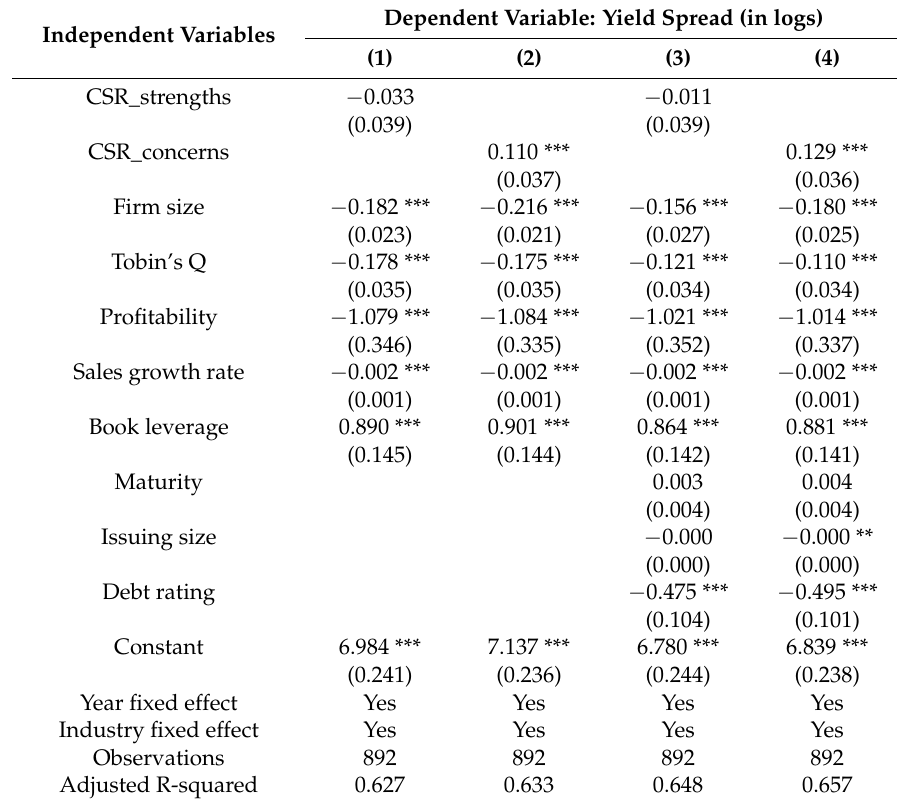
Table 3. Baseline regressions relating CSR to bond yield spread at issuance under Rule